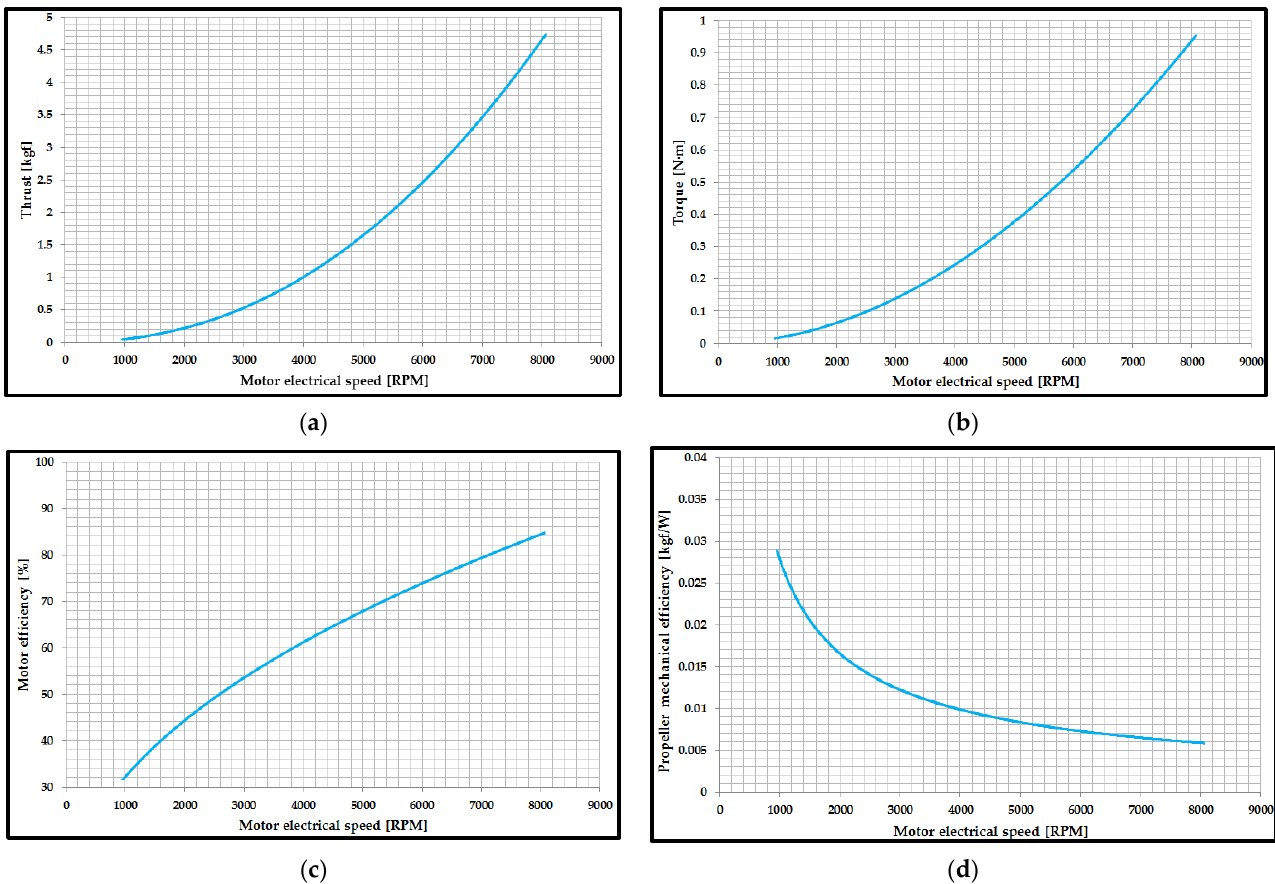
Figure 10. The performances of the BLDC motor manufactured via the SLS process: ( a ) thrust variation according to motor electrical speed; ( b ) variation of torque according to motor electrical speed; ( c ) motor efficiency variation according to motor electrical speed; ( d ) variation of propeller mechanical efficiency according to motor electrical speed.